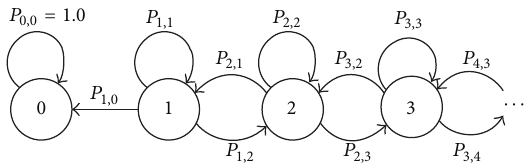
Figure 2: Markov chains model on tokens’ movement between